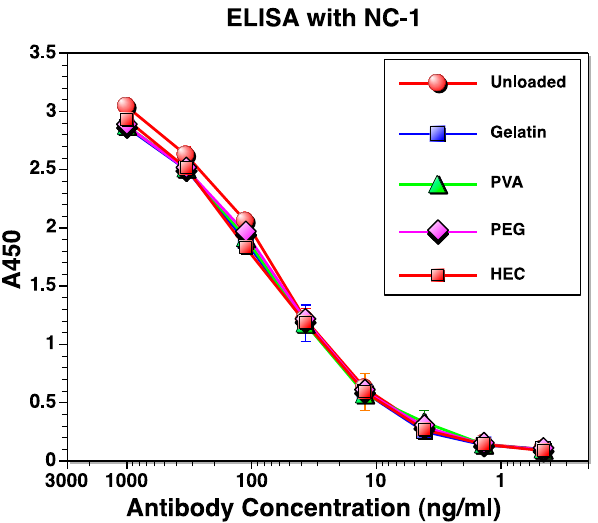
Figure 5. Structural conservation of released protein from different IPNFs. Labeled protein released from IPNFs cross-linked with 1 vol % GA was compared with unloaded labeled protein using ELISA with a NC-1 monoclonal antibody.